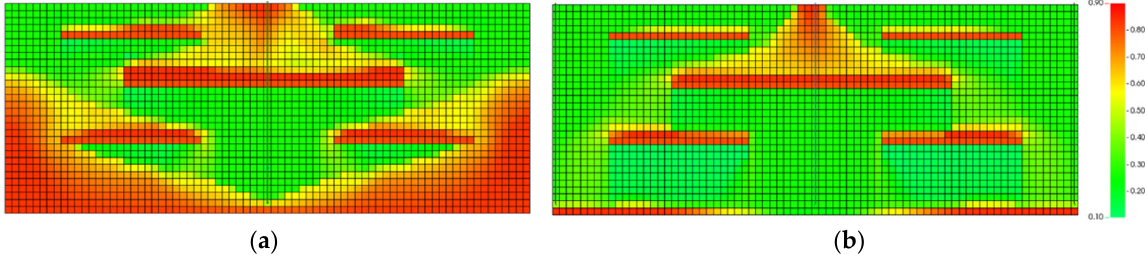
Figure 6. Comparison of oil saturation at the end of the ( a ) SAGD process and ( b ) bottom ‐ up assisted pressure drive process indicating that bottom ‐ up assisted pressure drive decreases residual oil.